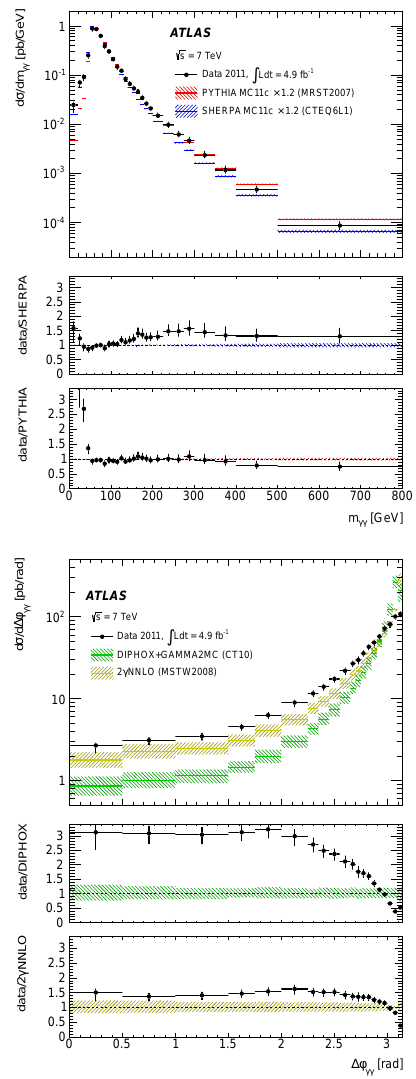
Figure 7. The di ff erential diphoton cross section as a func- tion of invariant diphoton mass M γγ (Upper) along with the pre- dictions from PYTHIA and SHERPA. The di ff erential diphoton cross section as a function of di ff erence in azimuthal angle be- tween two photons ∆ φ γγ (Lower) along with the predictions from DIPHOX + Gamma2MC and 2 γ